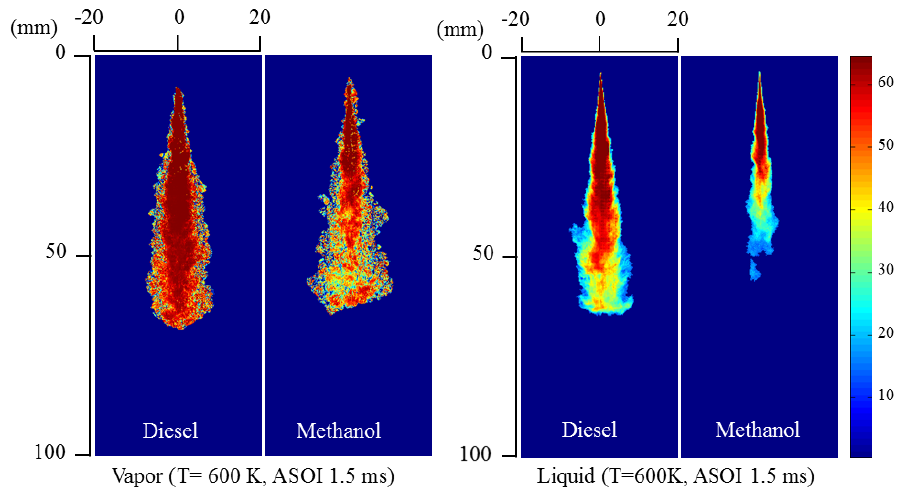
Figure 7. Typical vapor and liquid phase spray images of methanol and diesel spray.